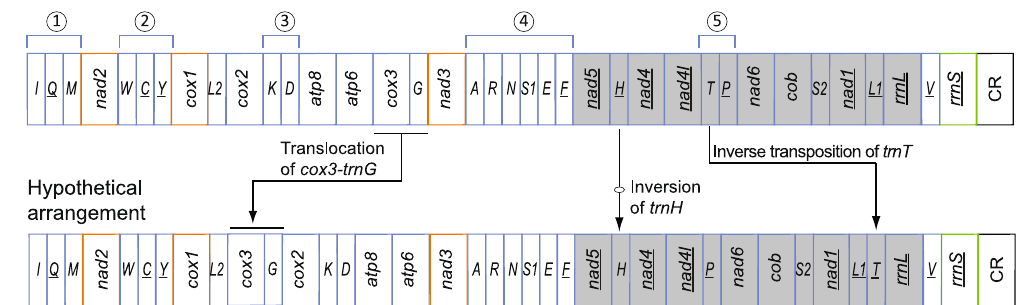
Figure 1. Ancestral arrangement of insect mitochondrial genes and types of gene rearrangement. The numbers 1 to 5 in circular indicate the five tRNA clusters. Transposition, inversion, inverse transposition were illustrated by comparing the ancestral pattern of insect mitochondrial gene arrangement and a hypothetical